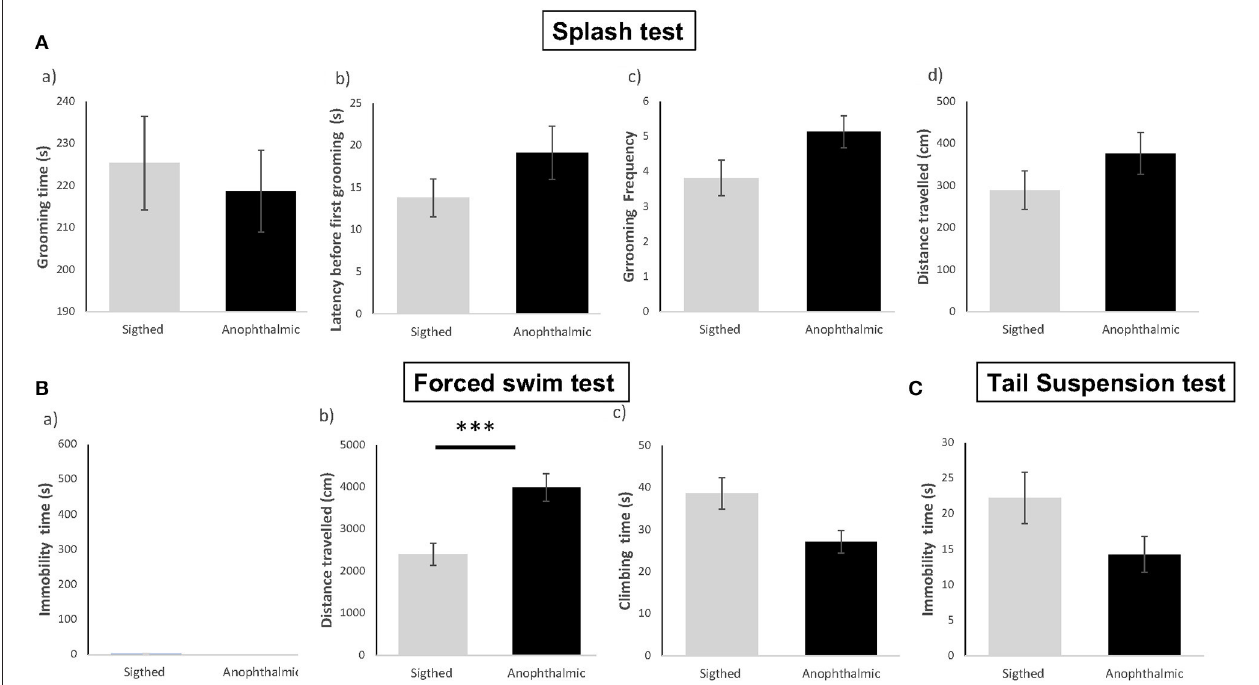
FIGURE 1 | Anophthalmic and sighted mice assayed to depression-like behavioral tests, such as the Splash Test (A) : Mean ( ± SE) of (a) time spent (s) Grooming, (b) Latency (s) before the first grooming, (c) Grooming Frequency, (d) Distance traveled (cm) in the device for a 10 min-test; and the Forced Swim Test (B) : (a) Immobility Time (s), (b) Distance traveled (cm), (c) Time spent climbing in the tank for a 6-min test, and the Suspension Tail test (C) : Immobility Time (s) for a 6-min test ( N = 15 and 17 mice/group, respectively *** p <